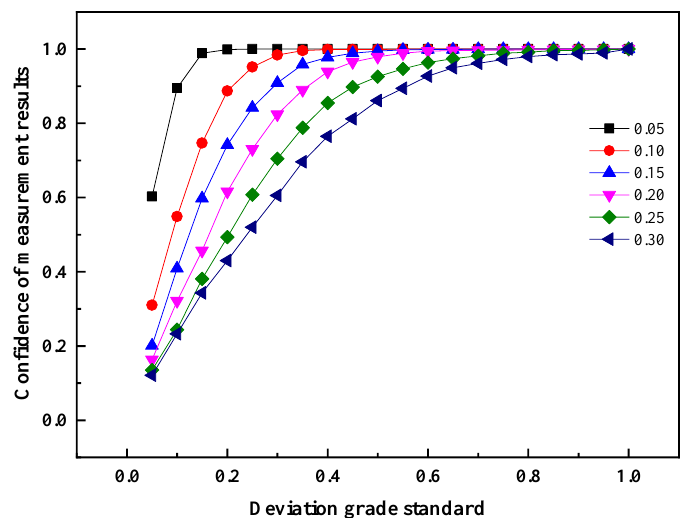
Figure 36. Relationship between deviation grade standard and confidence of measurement results